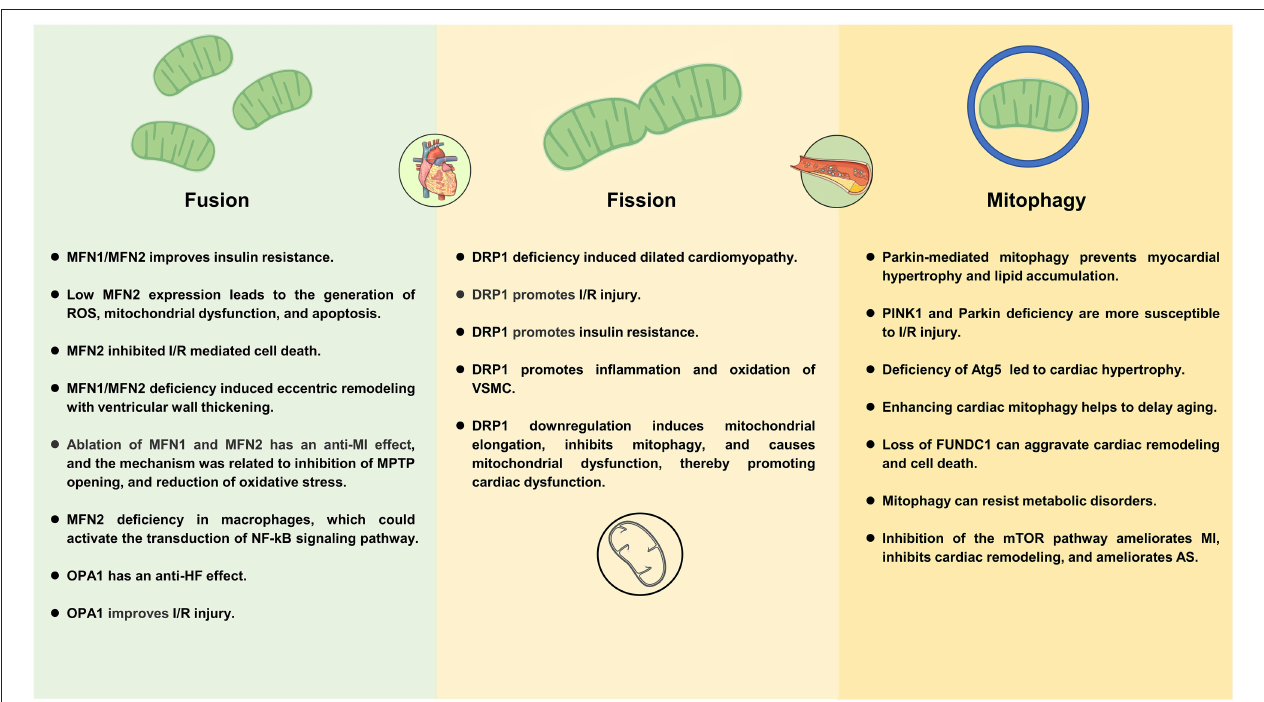
FIGURE 3 | Mechanisms of mitochondrial dynamics and mitophagy in cardiometabolic